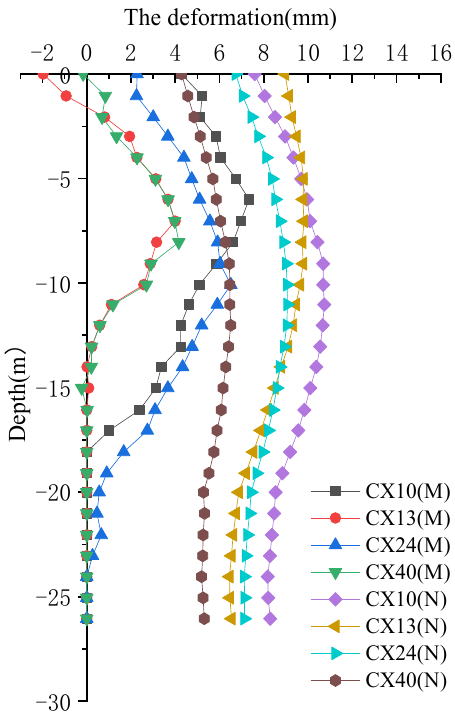
Figure 28. Comparison of the deformation for the retaining structure.